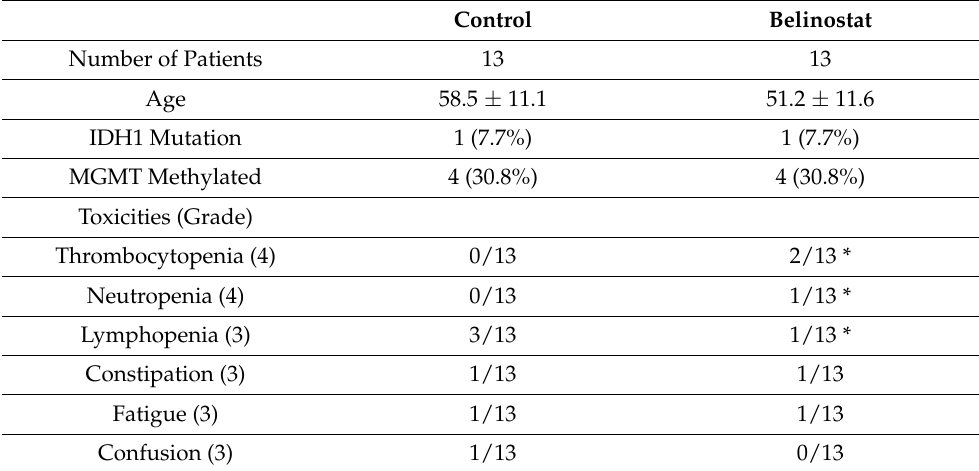
Table 1. Summary statistics for both cohorts including tabulation of significant toxicities ( ≥ grade 3) in all patients. * All occurrences were at 750 mg/m 2 /day